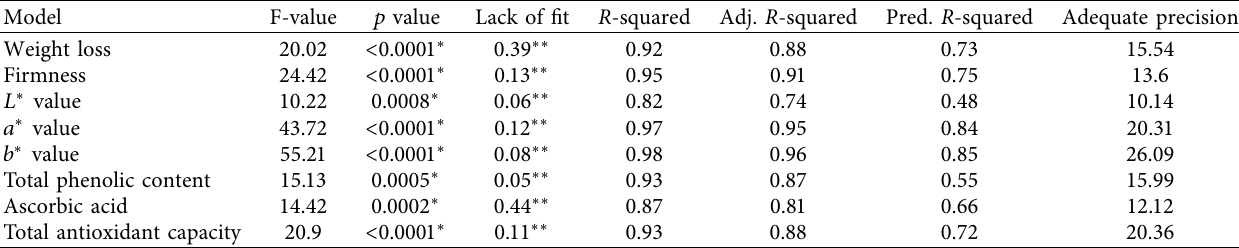
Table 2: Response surface methodology Box–Behnken design model ftting statistics.